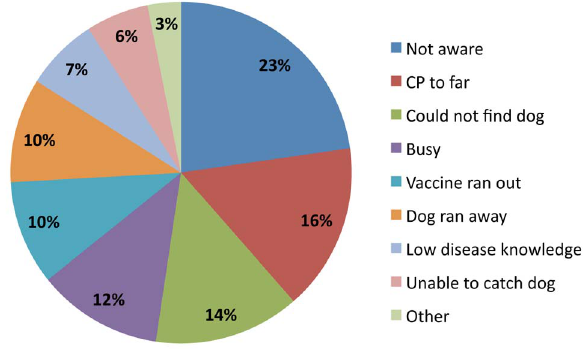
Figure 3. Reasons given for non-compliance with vaccination. Results from the population-based survey, including n=750 household respondents without vaccinated dogs considered old enough for